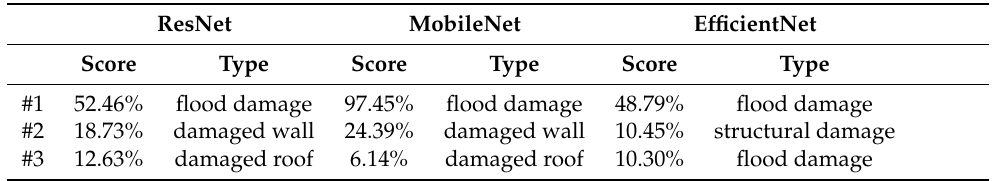
Table 6. Summary of confidence scores and associated object categories for the top three predictions made on the image of flood damage for each of the three